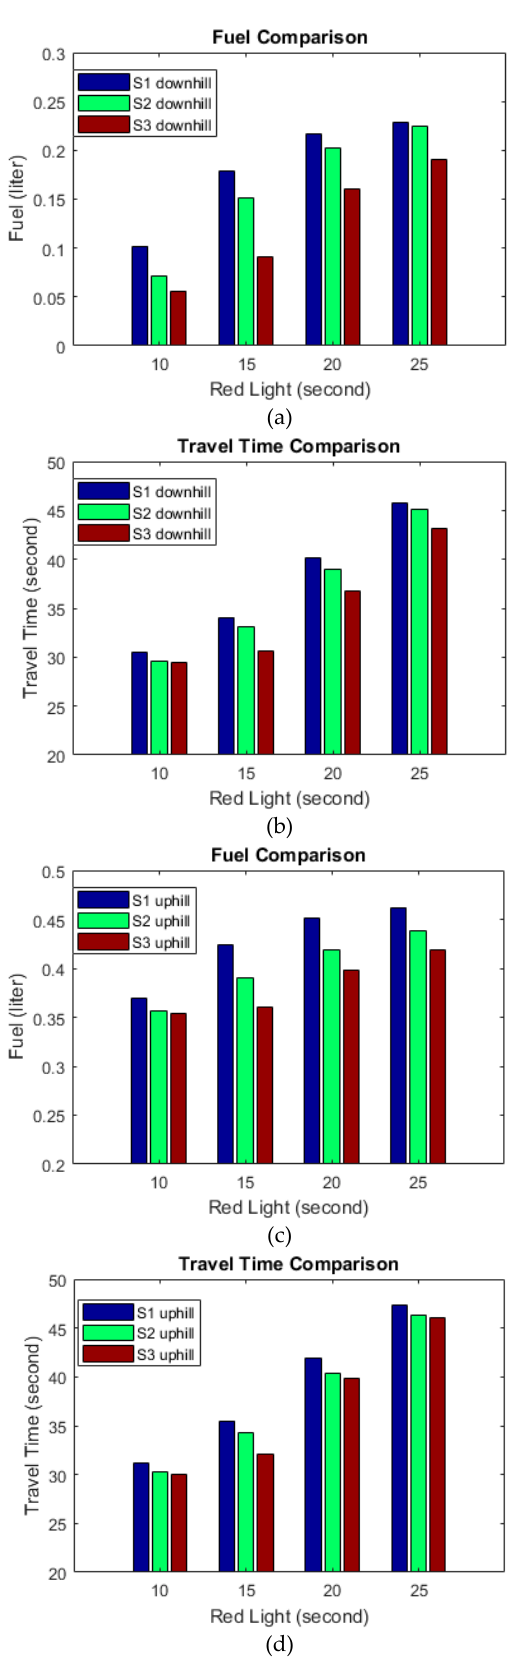
Figure 6. Comparison of test results for fuel levels and travel times: ( a ) fuel in downhill; ( b ) travel time in downhill; ( c ) fuel in uphill; ( d ) travel time in uphill